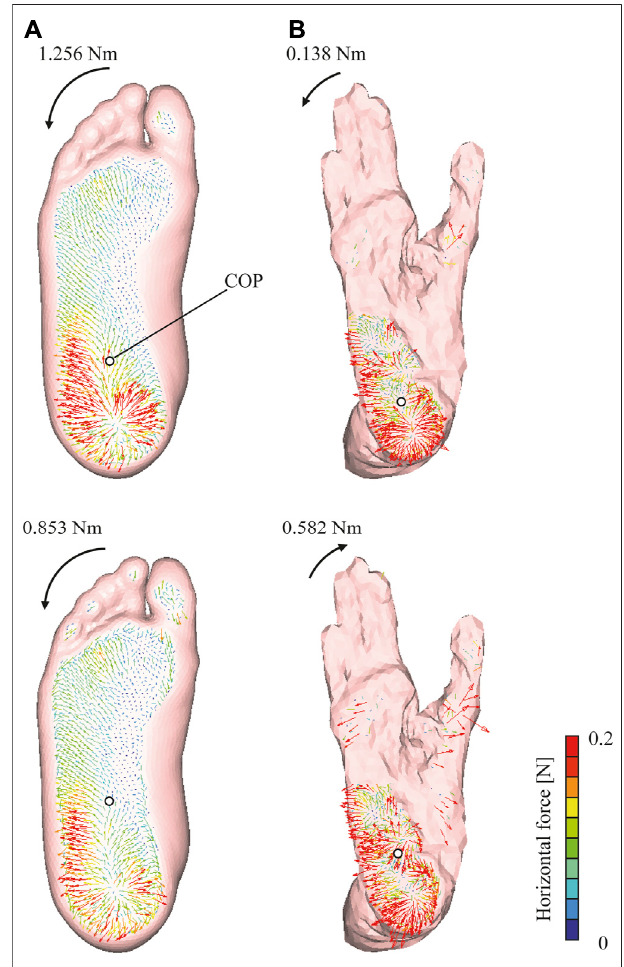
FIGURE 6 | Horizontal ground reaction force vector distribution in human (A) and chimpanzee (B) feet. Upper and lower rows represent force vector distributions of axially loaded foot without tendon traction and during quiet standing, respectively. Vectors illustrate forces exerted to ground from foot. Color or length of vector represents force magnitude. Calculated COP depicted as white circle. Magnitude and direction of VFM around COP are